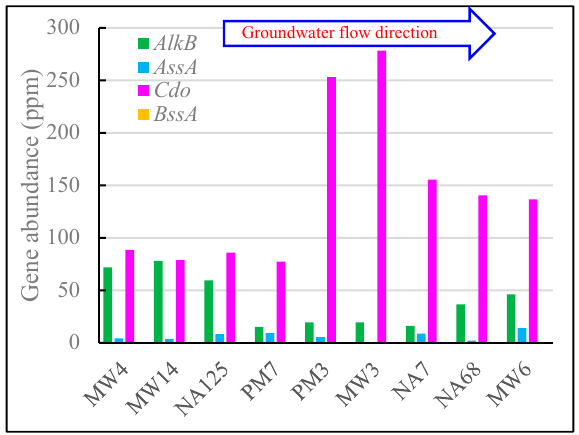
Figure 7. Distribution of AlkB , AssA , Cdo , and BssA genes in the aquifer.